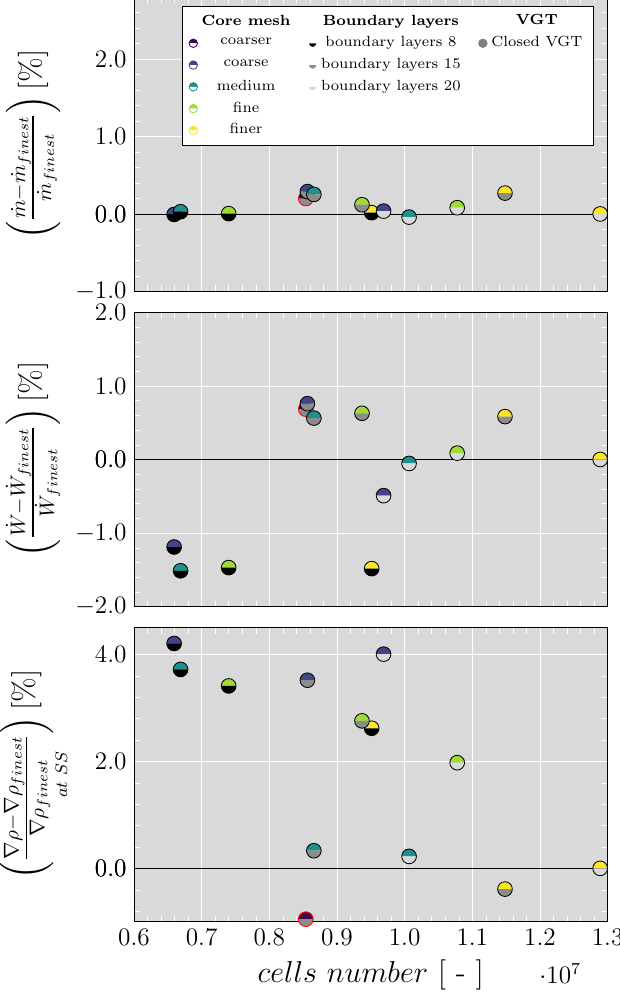
Figure 5. Mesh analysis Part A. The red dot corresponds to the mesh parameters used with the case without